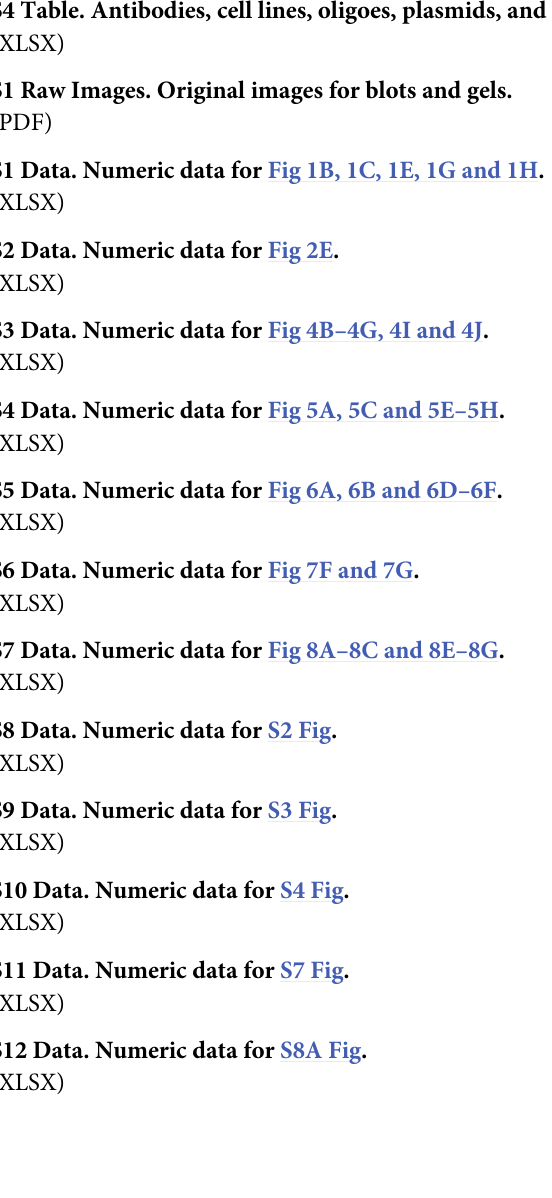
S3 Table. Ctnnb1 binding regions determined by Cut&Run in mESCs. S4 Table. Antibodies, cell lines, oligoes, plasmids, and chemicals used in this